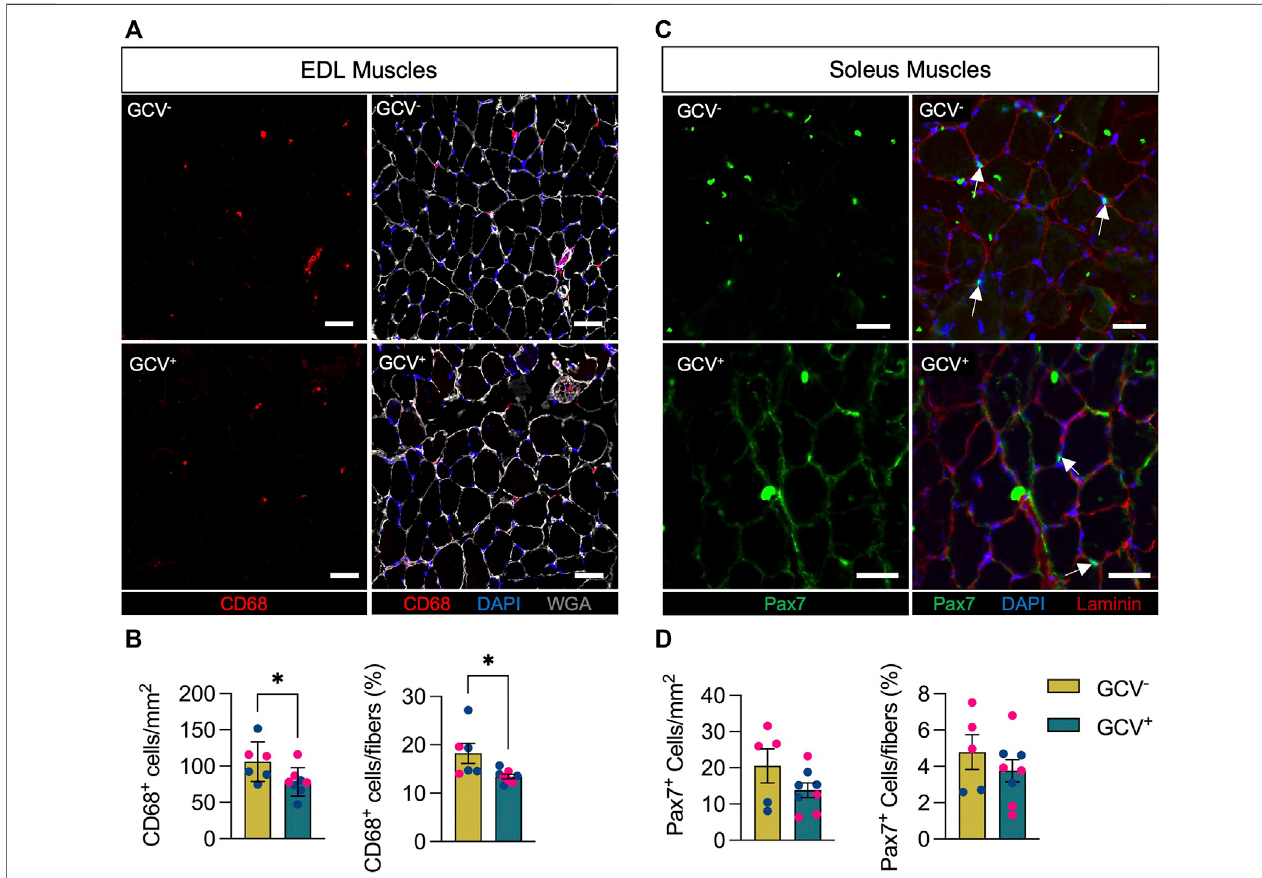
FIGURE 4 | CD68-positive but not Pax7-positive cells were reduced in GCV + mice. (A) Representative images are shown for cross sections of extensor digitorum longus (EDL) muscles stained with an antibody to the macrophage marker CD68 (red) as well as wheat germ agglutinin (WGA, white) and DAPI (blue). (B) Data showing countsofintramuscularCD68-positivecellsareshownforcrosssectionsfromganciclovir(GCV + )andvehicletreated(GCV − )mice. (C) Representativeimagesareshown for cross sections of soleus muscles stained with an antibody tothe satellite cell marker Pax7 (green) aswell aslaminin (red) and DAPI (blue). White arrows indicate Pax7-positivecellsthatoverlap withDAPIand arebetweensarcolemma andbasallaminaofmuscle fi bers. (D) DatashowingcountsofintramuscularPax7-positive cells are shown for cross sections from ganciclovir (GCV + ) and vehicle treated (GCV − ) mice. For both CD68 and Pax7, cell counts are expressed either relative the area analyzed (mm 2 ) or by the number of muscle fi bers in the sections (%). Bars show the mean ± SEM of fi ve to eight mice per group with dots representing data from each individual mouse. Blue and red data points represent male and female mice, respectively. *Denotes p < .05 between groups by two-tailed unpaired t-test. Scale bar = 50 μ m.